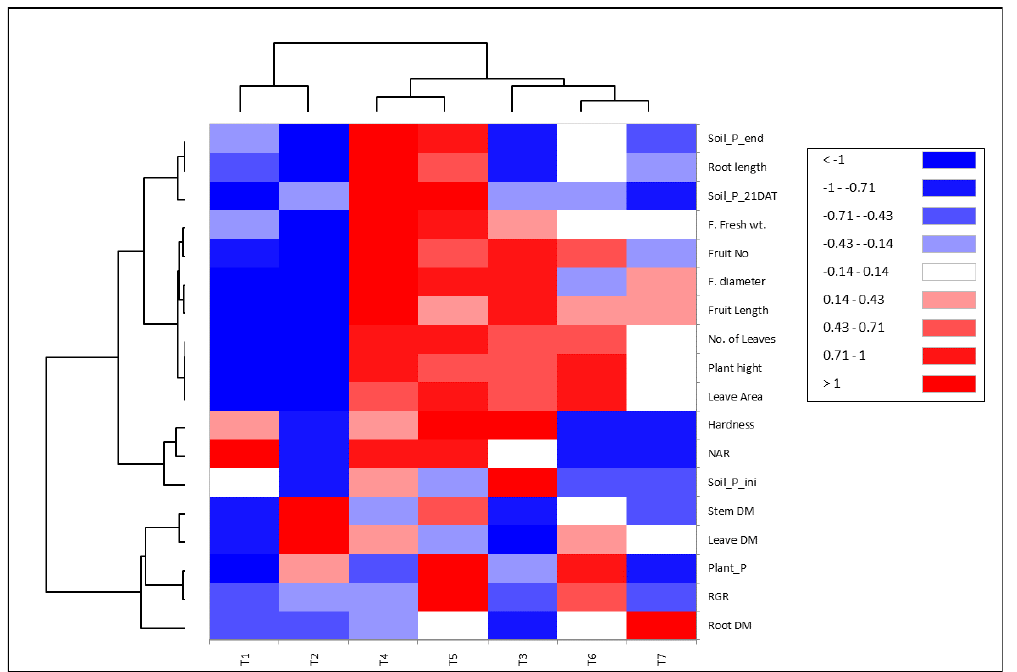
Figure 7. Heatmap correlation between evaluated traits and appropriate treatments from Streptomyces strains with rock phosphate.